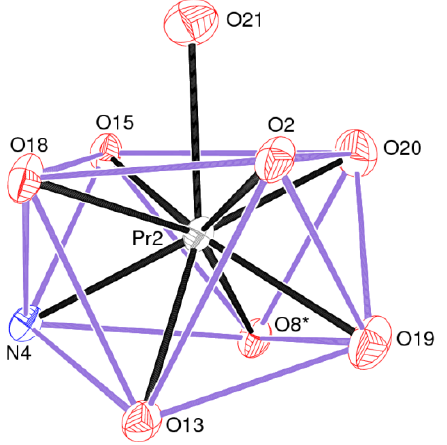
Figure 3. Detail of 1 (50% displacement ellipsoids) showing the mono-capped square anti-prismatic coordination of Pr2. O18, O19, O20 and O21 are parts of water